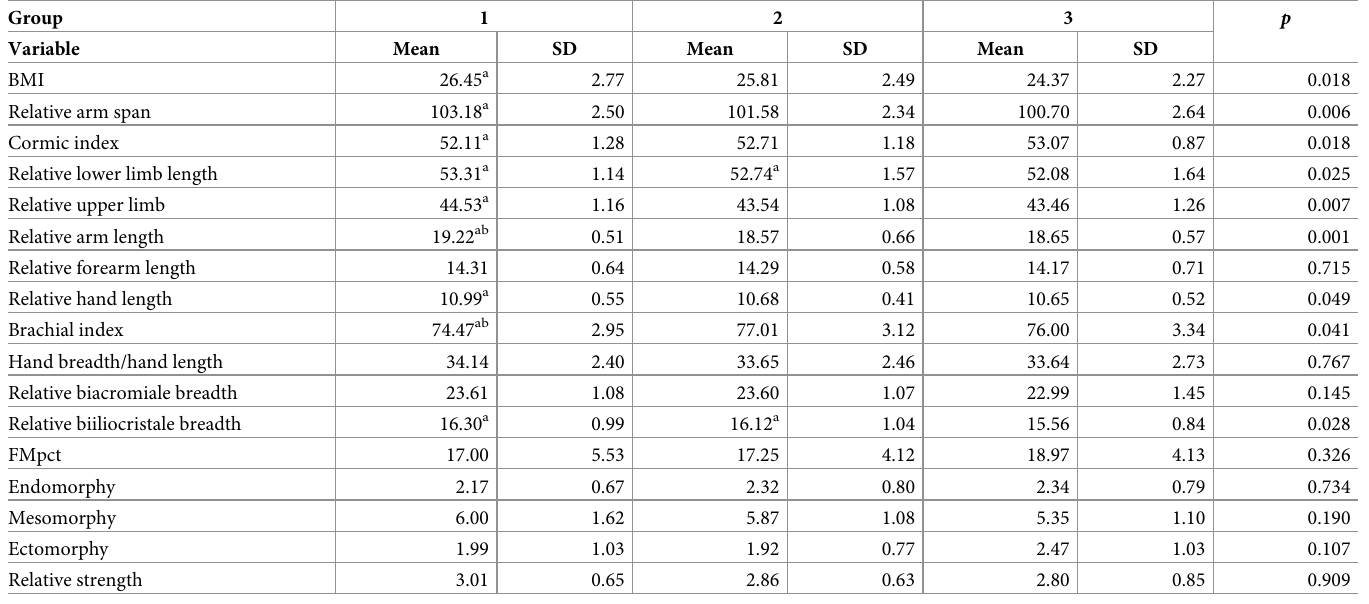
Table 2. Statistical characteristics and inter-group differences of the morphological traits in handball players (SD–standard